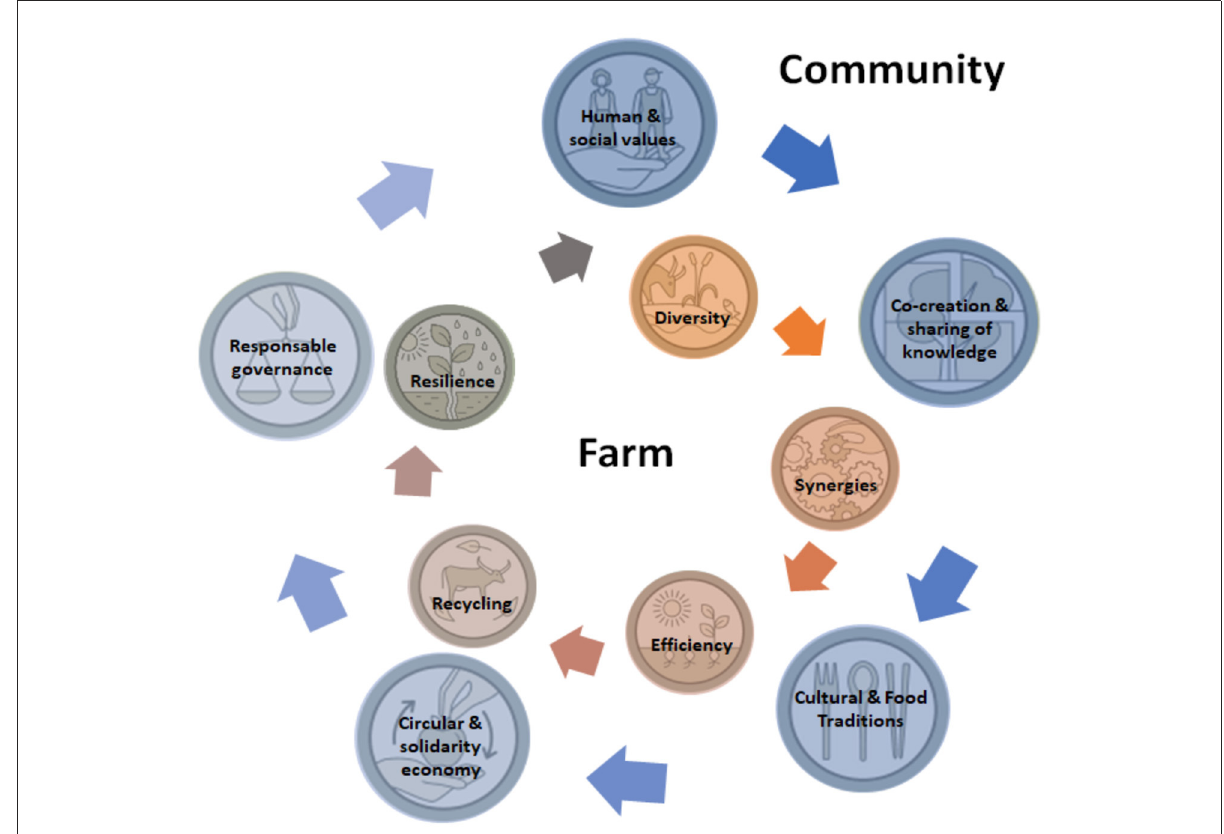
FIGURE1 The 10 elements that define agroecology, used in the TAPE framework, represented as those that operate mainly at farm (grey-orange) or mainly at community (blue) level. Principles such as resilience, recycling or synergies operate also at community level, but they are assessed using farm-level indicators within the TAPE